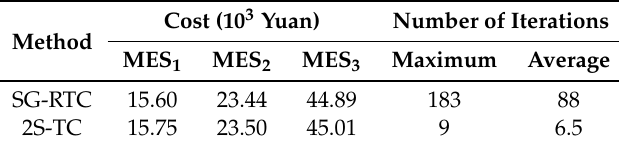
Table 3. Comparisons of subgradient-based rolling TC (SG-RTC) and